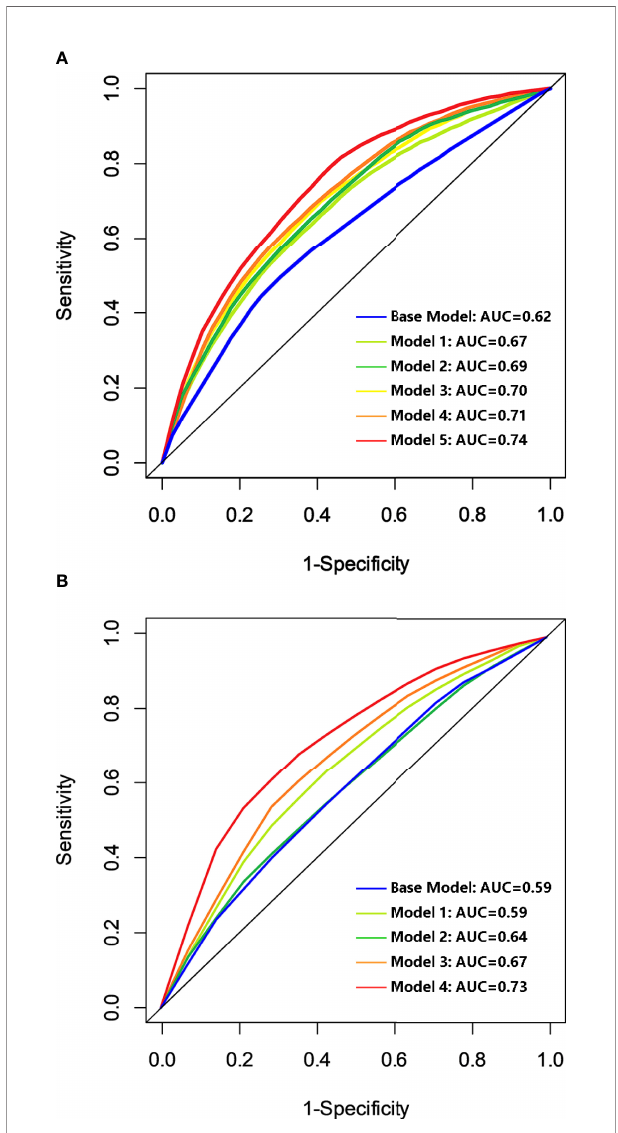
FIGURE 4 | Discriminatory accuracy of the models for OS (A) and DFS (B) . Base model was based on the BCLC stage, differentiation, MVI status, and cirrhosis status; model 2 to model 5 were built by adding predictive immunologic variables of CD8, OX40, CD68, CD66b, and TILs successively for OS. Model 2 to model 4 were built by adding the predictive immunologic variables of CD8, OX40, CD66b, and TILs successively to the base model for DFS. OS, overall survival; DFS, disease-free survival; AUC, area under the curve; BCLC stage, Barcelona Clinic Liver Cancer stage; MVI, microvascular invasion; TILs, tumor-in fi ltrating